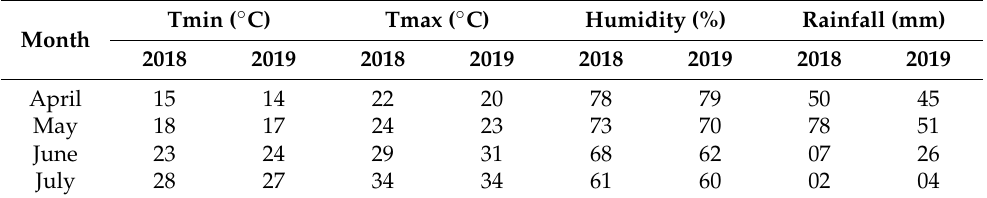
Table 1. Weather data recorded for the two tomato growing years in 2018 and